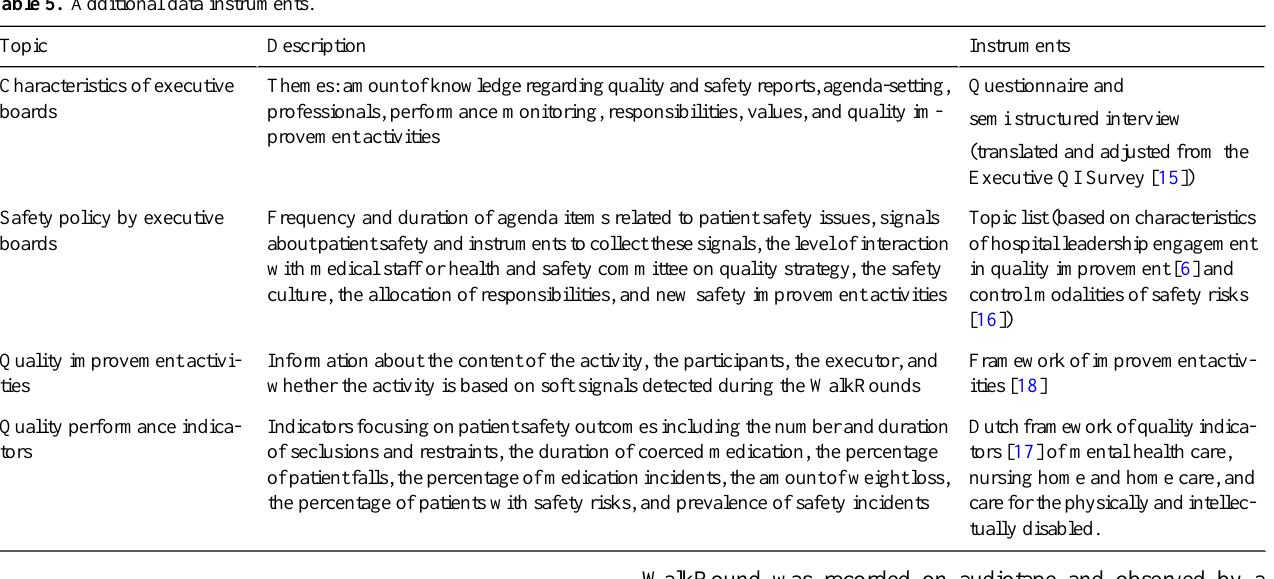
Table 5. Additional data